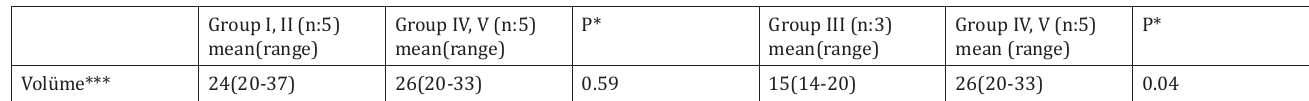
Comparison of pressure and volume measurements of the BAMA augmented cystoplasty groups (Group IV + Group V) with the partial cystectomy only group (Group III) and control groups (Group I + Group II).